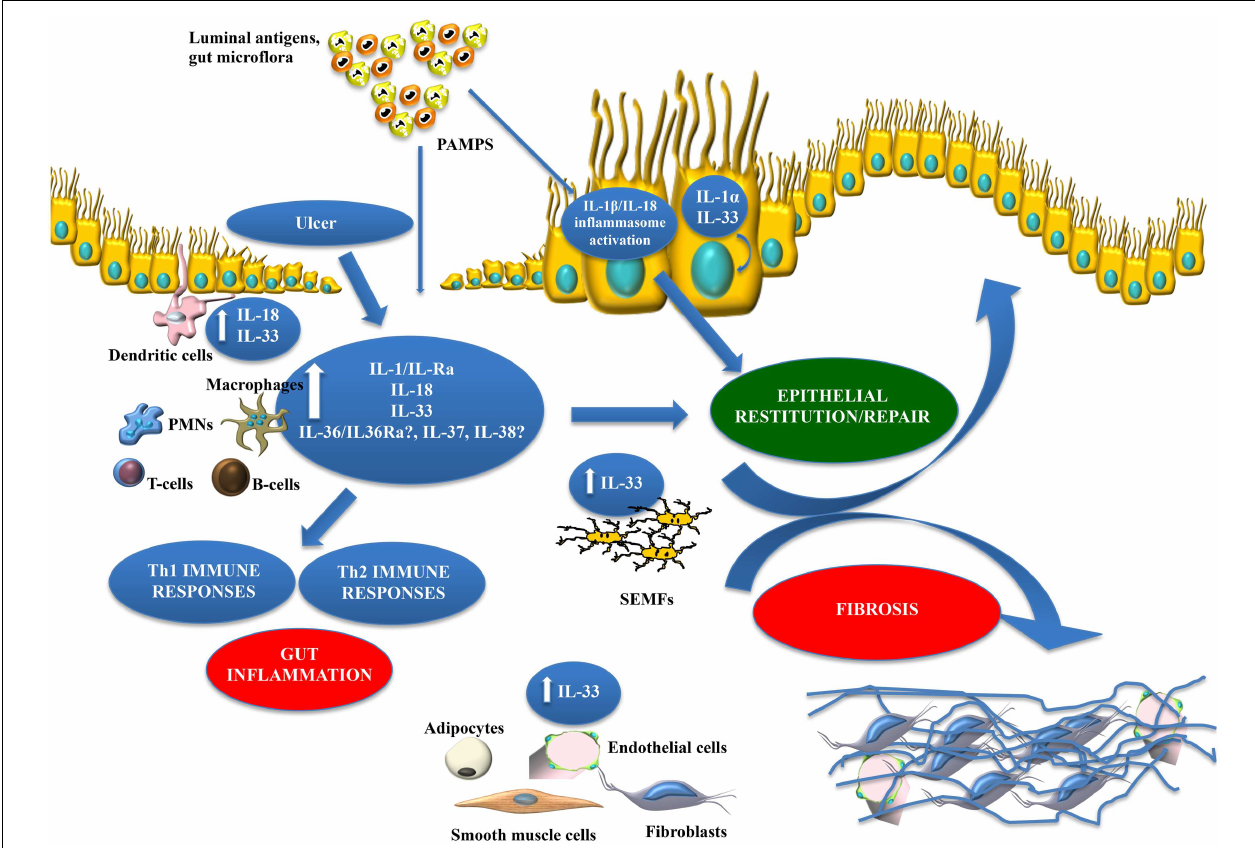
including macrophages, andT- and B-cells, eliciting a pro-inflammatory response and promotingTh2 immunity. Concomitantly, IL-33 can also induce epithelial proliferation and repair, and overall wound healing by acting directly or indirectly on IECs and SEMFs. Alternatively, chronic mucosal damage, granulomatous inflammation, and dysregulated activation of mesenchymal cells, such as SEMFs and fibroblasts, can lead to fibrosis and the formation of intestinal fibrotic lesions.Therapeutic interventions should consider all of the aforementioned processes and whether targeting specific IL-1 family members may be more efficacious during active disease vs. maintaining